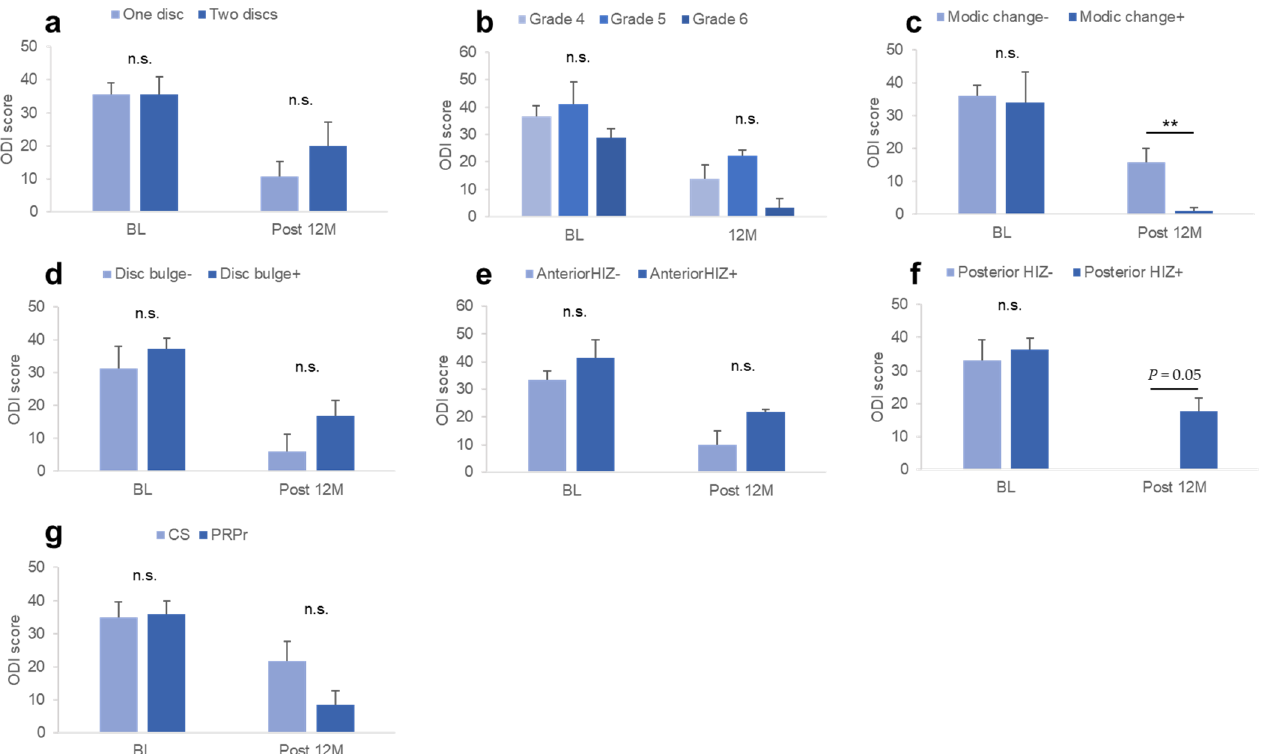
Figure 3. ODI at baseline and Post 12 M. ODI at baseline and Post 12 M among the groups classified by the image characteristics of the targeted discs, including ( a ) number of targeted discs, ( b ) modified Pfirrmann grading, ( c ) Modic changes, ( d ) disc bulge, ( e ) anterior HIZ, ( f ) posterior HIZs, and ( g ) treatment group. ODI, Oswestry Disability Index; CS, corticosteroid; PRPr, platelet-rich plasma releasate; HIZ, high-intensity zone. ** p < 0.05 between the groups. At baseline, there were no significant differences in the change in ODI between the groups classified according to the image characteristics of the targeted discs or treatment group (Table 3). The % change in ODI was significantly lower in patients without Modic changes compared to those with Modic changes ( p < 0.05) and in patients with posterior HIZs compared to those without posterior HIZs ( p < 0.05; Table 3). Segmental